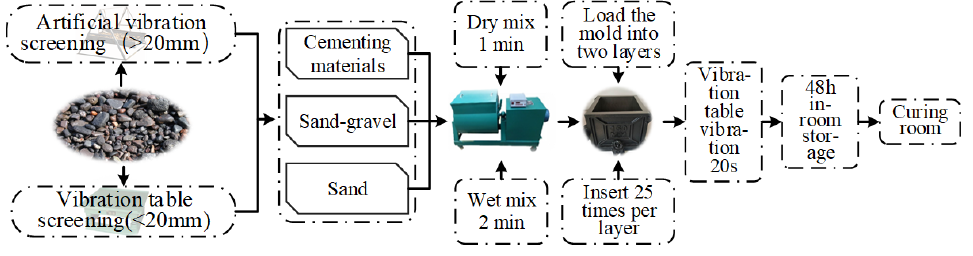
Figure 1: Specimen preparation process